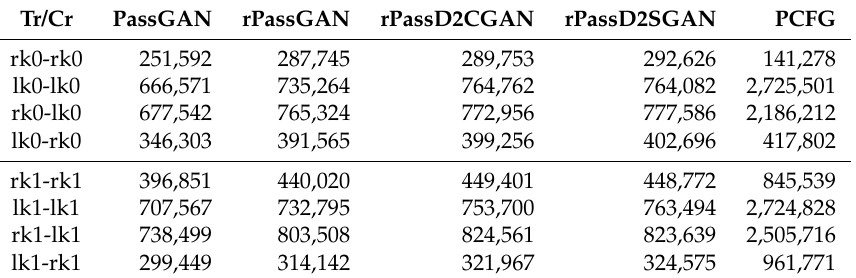
Table 2. Password cracking performance